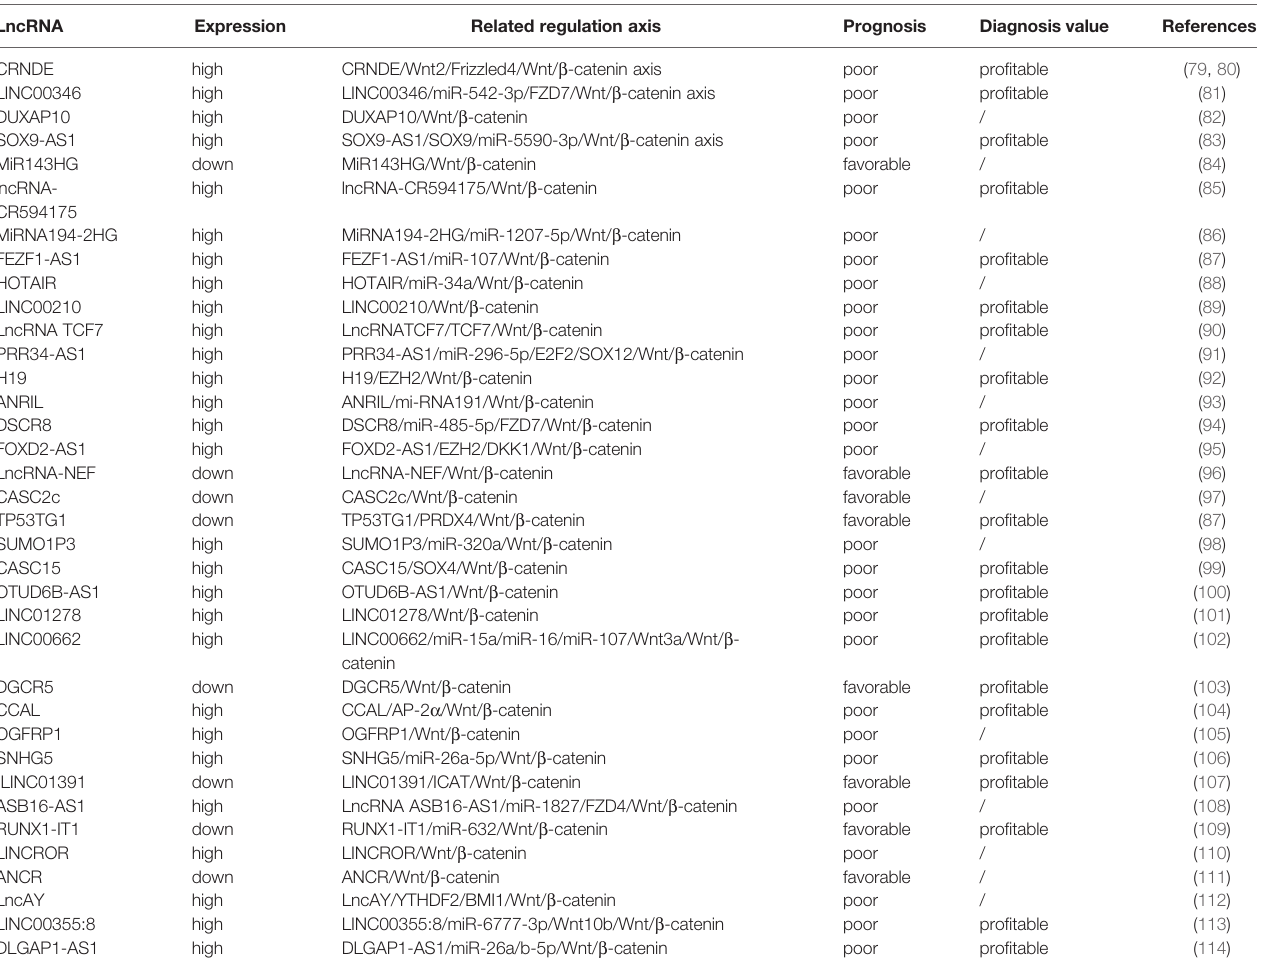
TABLE 1 | Expression of lncRNAs in related lncRNA/Wnt/ b -catenin axes in HCC. LncRNA